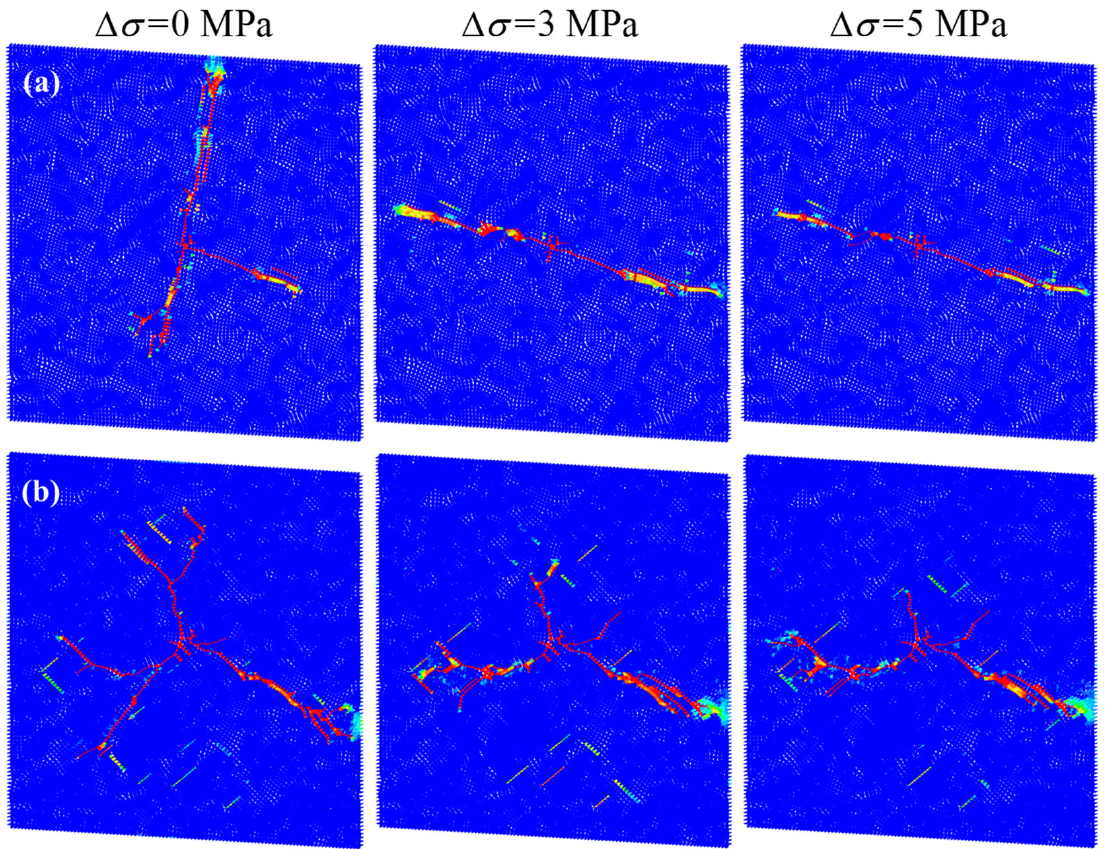
Figure 8. Fracturing results of group A ( a ) and group B ( b ) under different ground stress differences. First line in subfigures represent the results of natural fracture group A and second line is group B